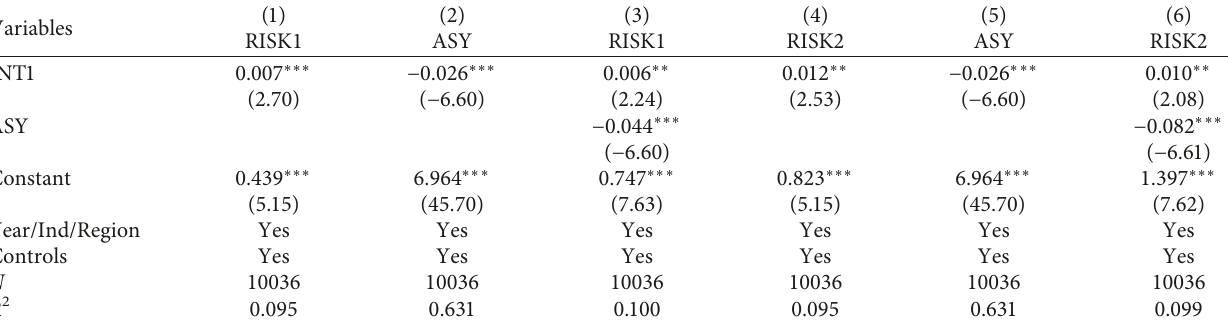
Table 4: Mechanism of action testing.